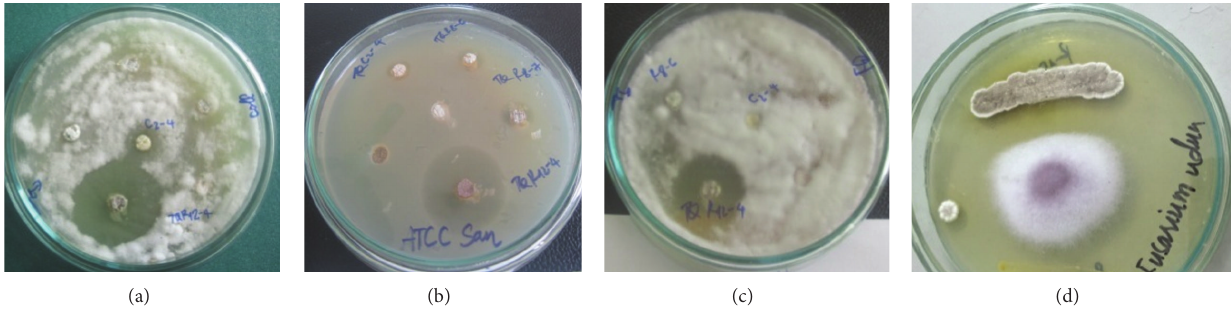
Figure 1: Screening of endophytic actinomycetes for antifungal and antibacterial activity. Test strains: C. truncatum VSVD 14 (a), S. aureus ATCC 25922 (b), F. oxysporum FO5 (c), and F. udum VSVD 4 (d).